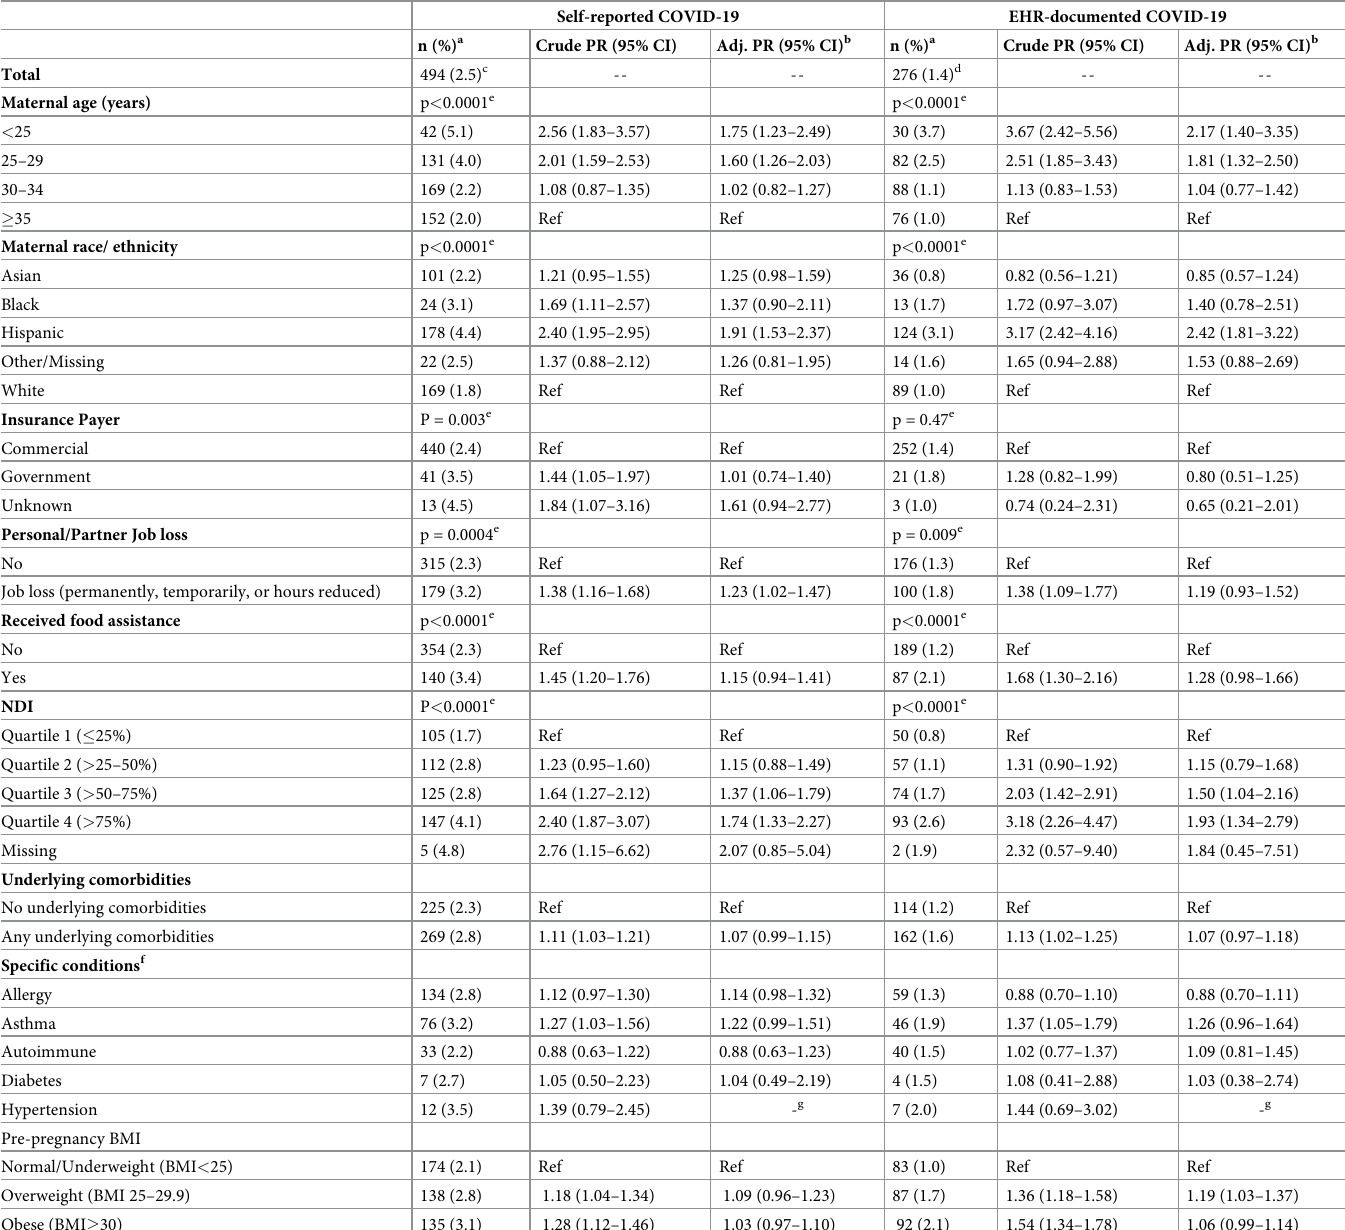
Table 2. Self-reported and EHR-documented COVID-19 prevalence by sociodemographic and clinical factors, crude and adjusted prevalence